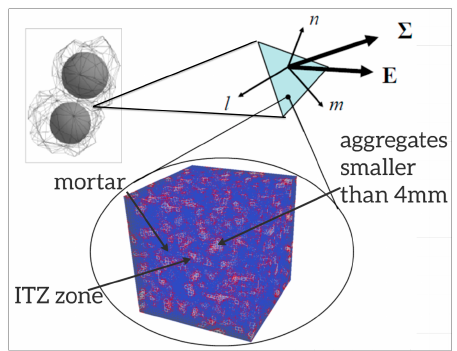
Figure 2. The location of the LDPM facet and its unit cell (mortar in Blue, ITZ in Red, and aggregates smaller than 4 mm in White).